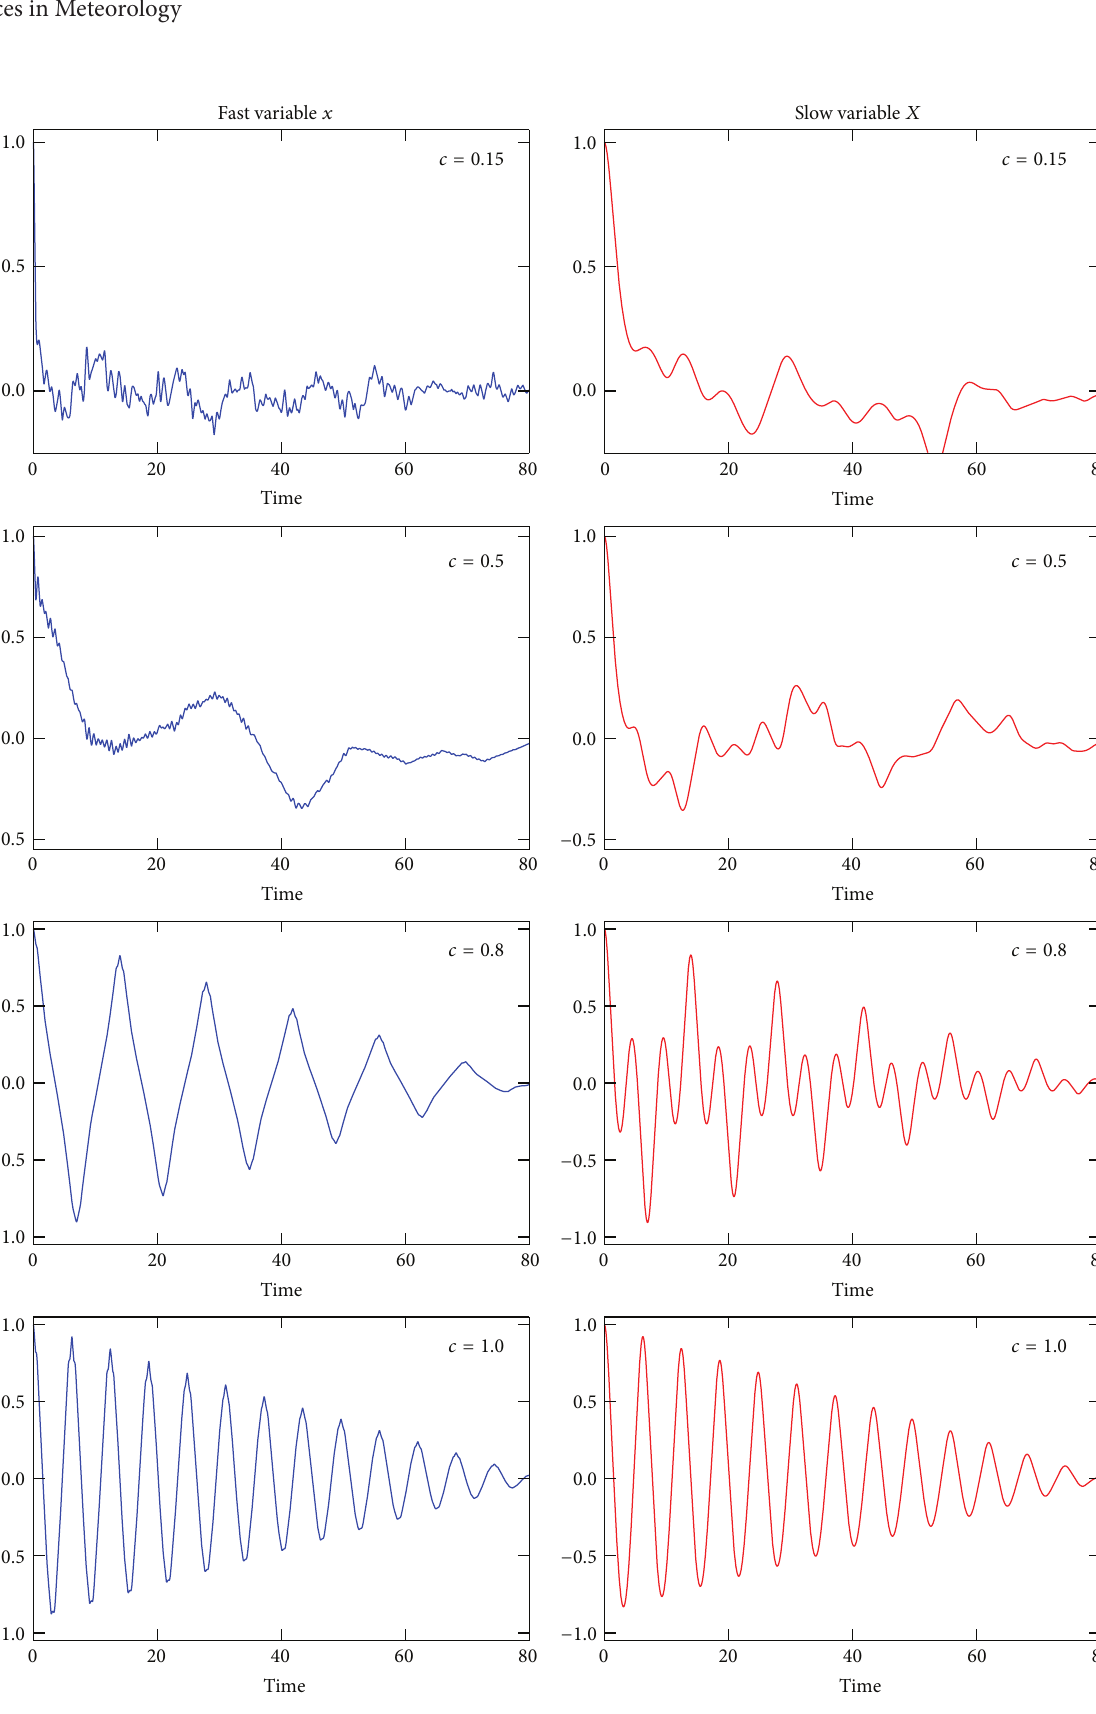
Figure 2: Autocorrelation functions for dynamic variables 𝑥 and 𝑋 for different parameter 𝑐